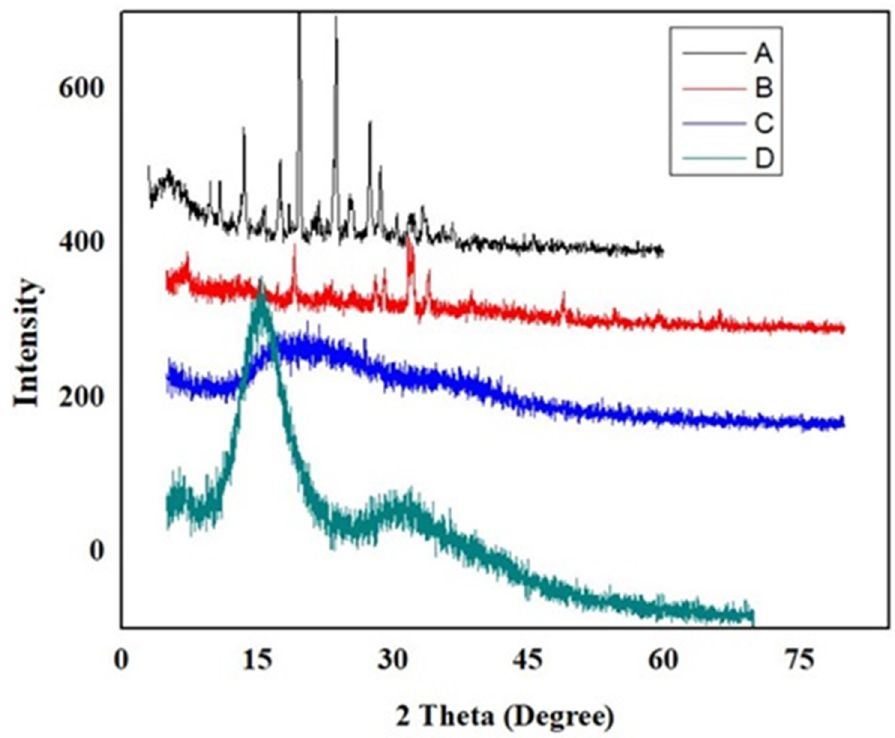
Figure 8. XRD diffractograms of ( A ) Diloxanide Furoate, ( B ) Na-Alg, ( C ) CP-934P, ( D ) Diloxanide Furoate loaded Na-Alg/CP-co-poly (methacrylate) hydrogel.